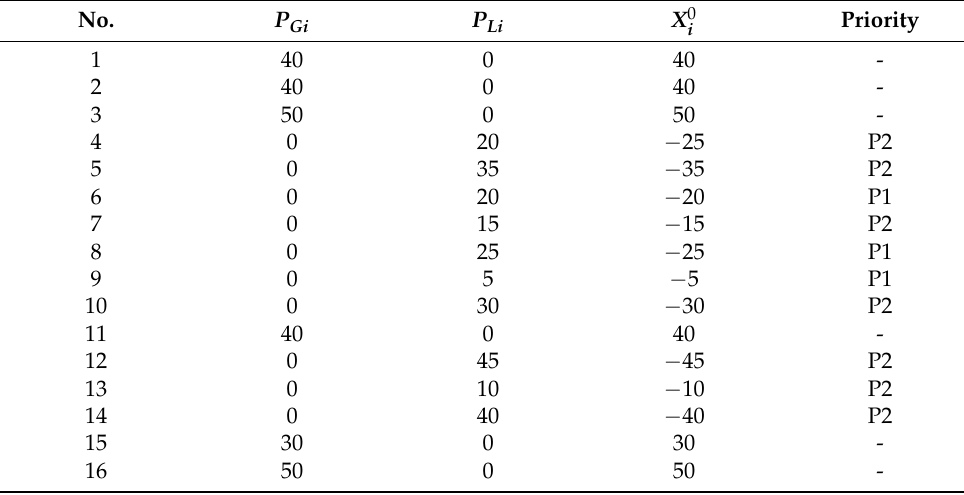
Table 3. Generation, load, and load restoration priority for the example in